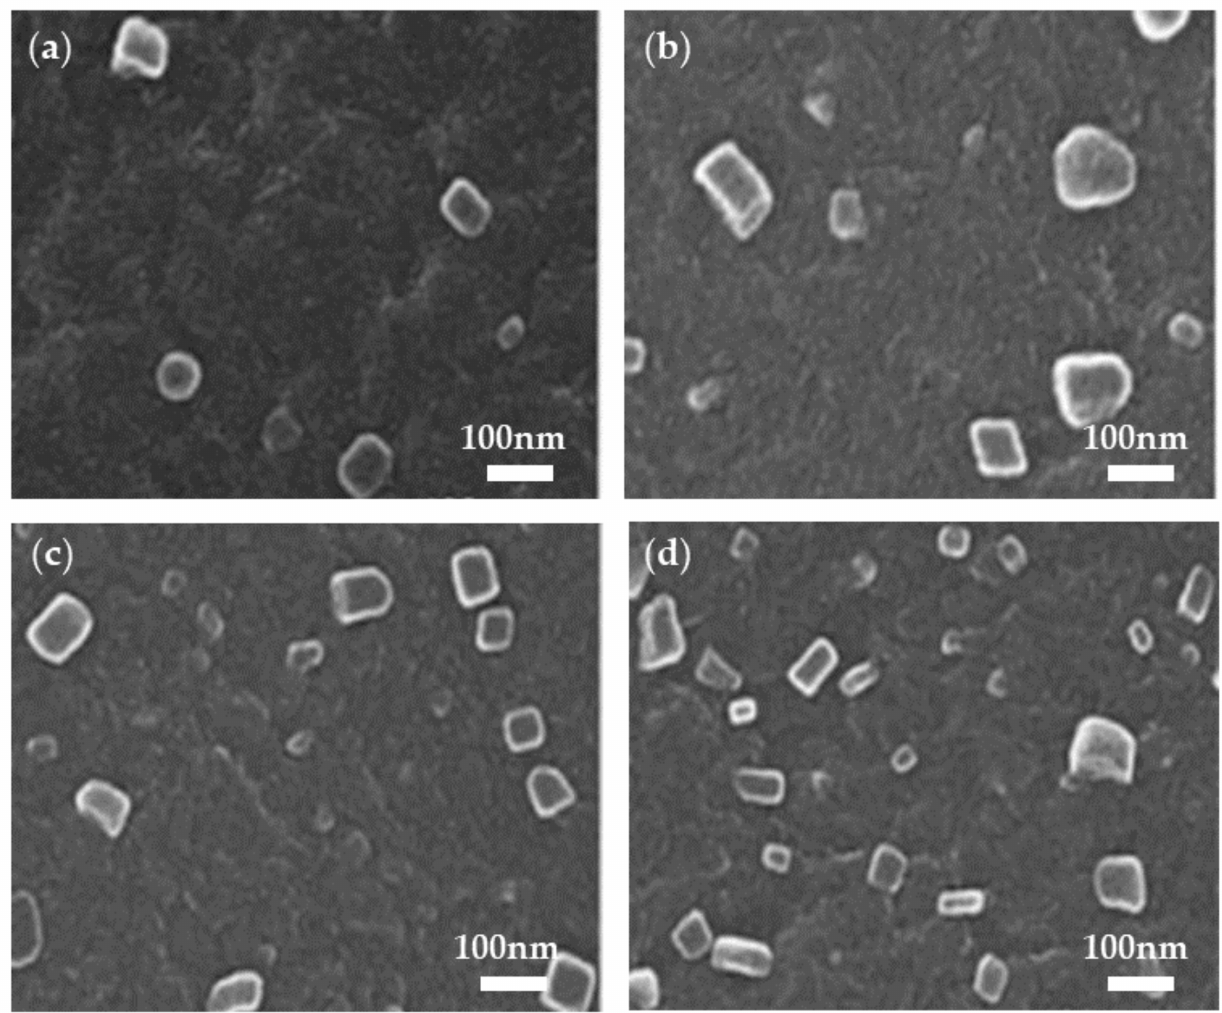
Figure 9. ( a ) SEM images of PVDF films with f PANI = 0.015; ( b ) f PANI = 0.040; ( c ) f PANI = 0.050; and ( d ) f PANI = 0.060. Reprinted with permission from [101]. Copyright (2010), Royal Society of